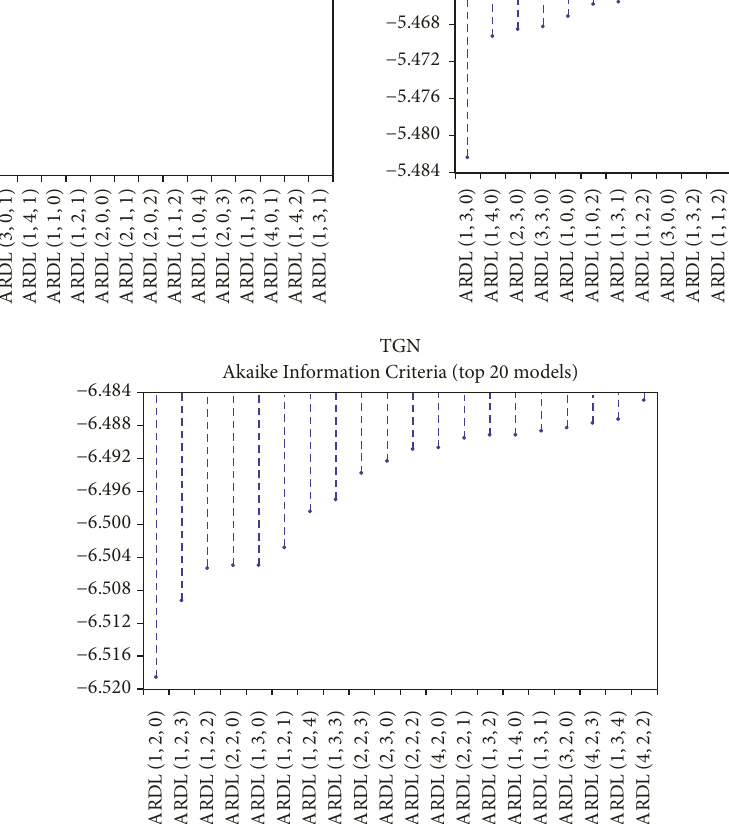
Figure 8: Akaike information criteria (AIC). Source: author’s own work. Notes: for the definition of variables, please see Table